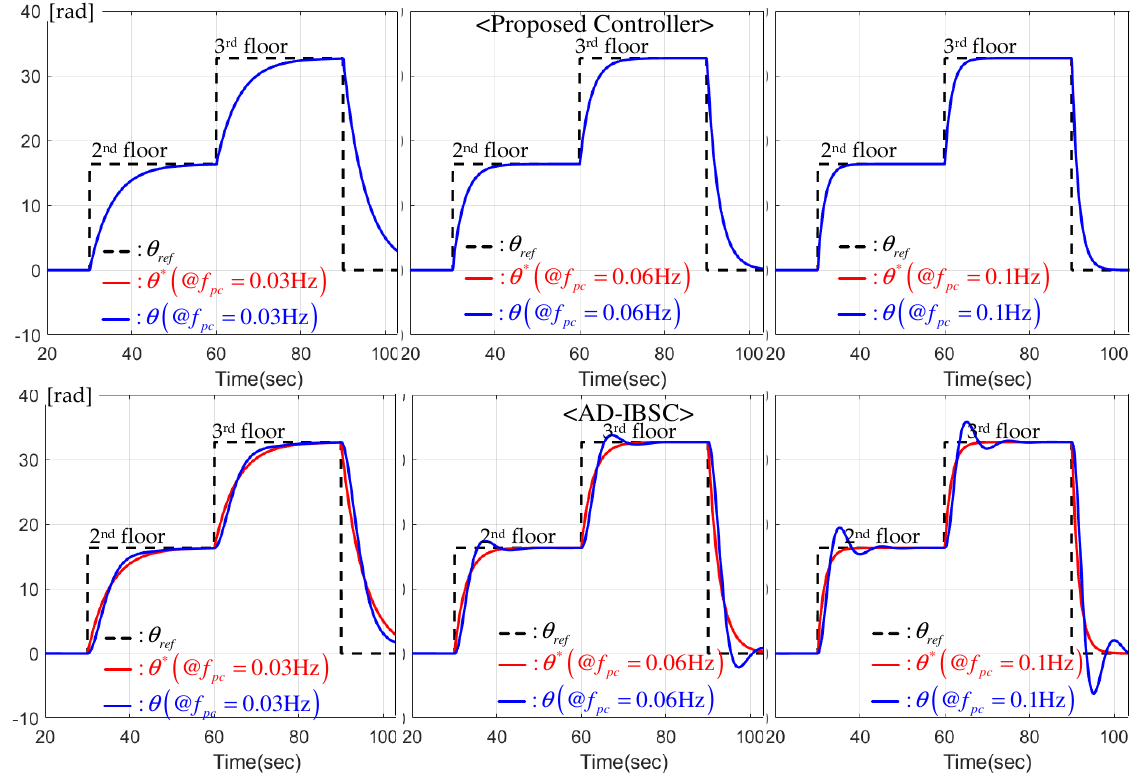
Figure 5. Position response comparison (master motor) for different outer loop cut-off frequency.